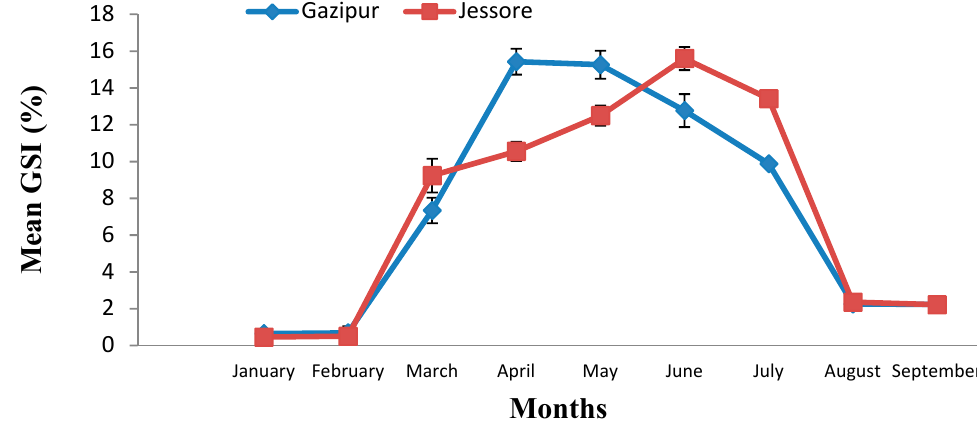
Figure 1. Monthly mean % of gonadosomatic index (GSI) of P. sophore in Gazipur and Jessore.